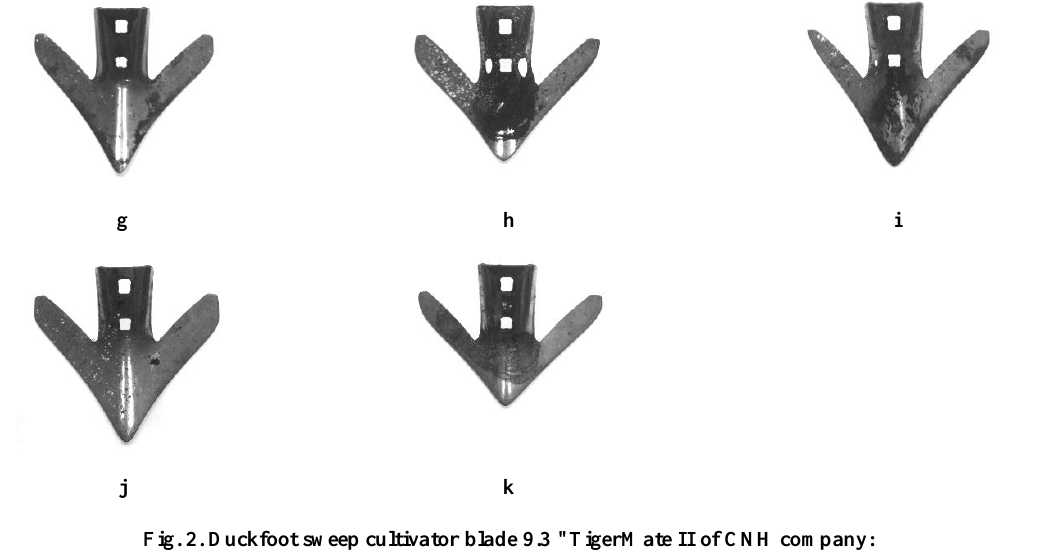
Fig. 2. Duckfoot sweep cultivator blade 9.3 "TigerMate II of CNH company: a - new; b - k - worn out